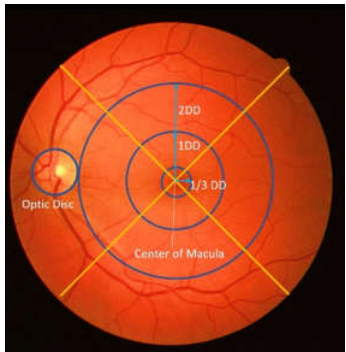
Figure 1. An example of polar coordinates in retinal image. (DD: disc diameter).